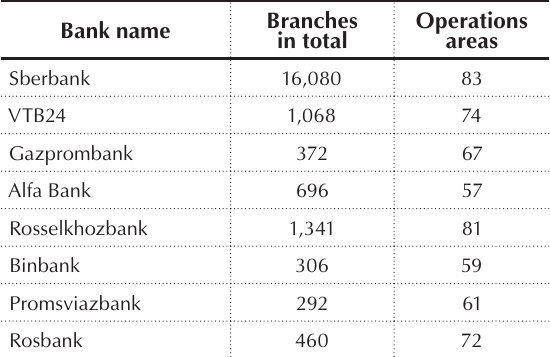
Table 3. (cid:62)(cid:286)(cid:258)(cid:282)(cid:349)(cid:374)(cid:336)(cid:3)(cid:271)(cid:258)(cid:374)(cid:364)(cid:400)(cid:3)(cid:449)(cid:349)(cid:410)(cid:346)(cid:3)(cid:258)(cid:3)(cid:296)(cid:286)(cid:282)(cid:286)(cid:396)(cid:258)(cid:367)(cid:3)(cid:374)(cid:286)(cid:410)(cid:449)(cid:381)(cid:396)(cid:364)(cid:3)(cid:381)(cid:296)(cid:3) (cid:271)(cid:396)(cid:258)(cid:374)(cid:272)(cid:346)(cid:286)(cid:400)(cid:3)(cid:258)(cid:374)(cid:282)(cid:3)(cid:400)(cid:437)(cid:271)(cid:400)(cid:349)(cid:282)(cid:349)(cid:258)(cid:396)(cid:349)(cid:286)(cid:400)(cid:3)(cid:258)(cid:400)(cid:3)(cid:381)(cid:296)(cid:3)(cid:58)(cid:258)(cid:374)(cid:437)(cid:258)(cid:396)(cid:455)(cid:3)(cid:1005)(cid:853)(cid:3)(cid:1006)(cid:1004)(cid:1005)(cid:1010)